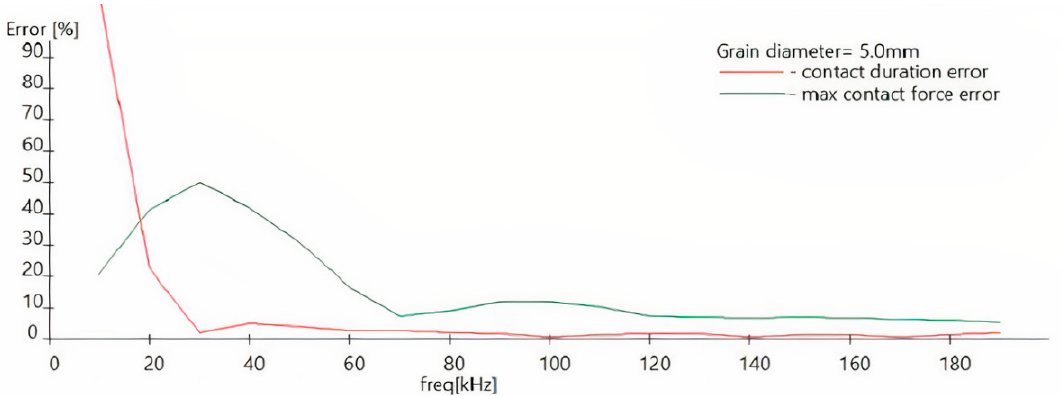
Figure 10. The error course of the contact time (red line) and the maximum impact force (green line) for grains of 5.0 mm diameter depending on the sensor resonance frequency function.